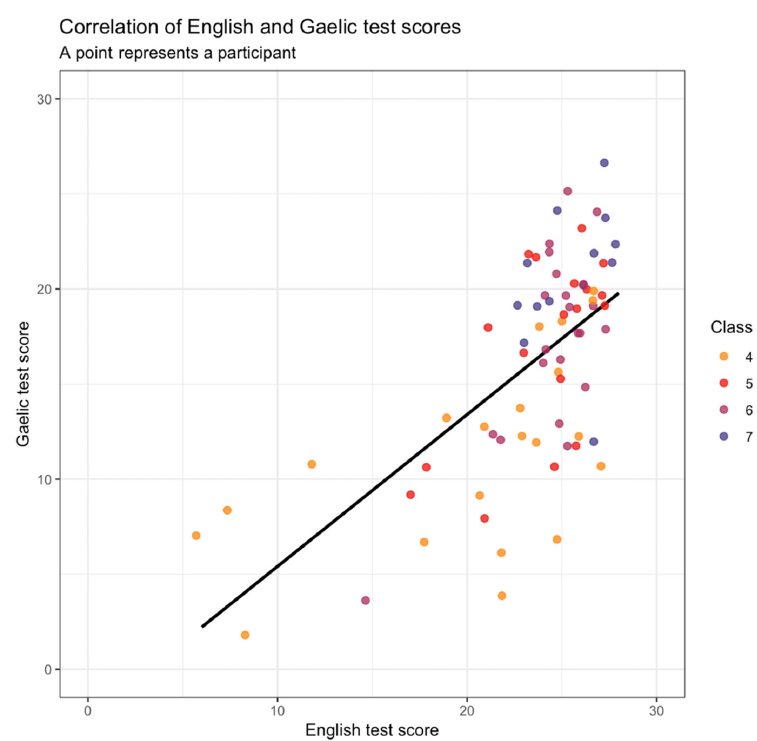
Figure 2. Correlation of the English and Gaelic test scores. The regression line is plotted in black, while the individual scores are shown as points colour-coded by school class.